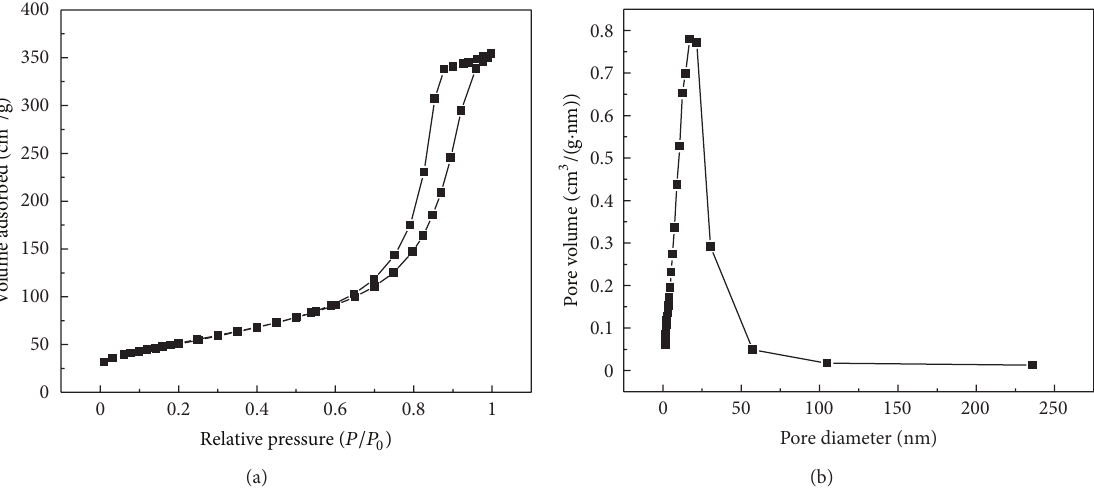
Figure 3: (a) Nitrogen adsorption-desorption isotherms and (b) corresponding pore size distribution curves of the as-synthesized TiO 2